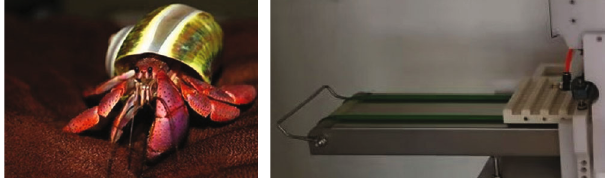
Figure 15: The biological prototype of the packaging